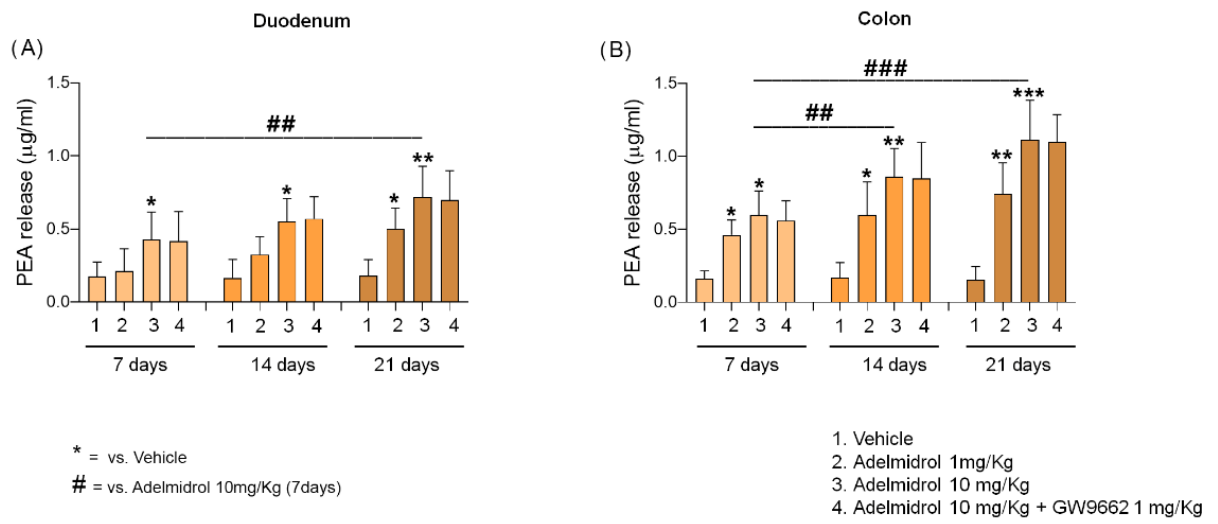
Figure 2. Effect of daily administration of Adelmidrol (1–10 mg/Kg) on PEA concentration in the duodenum ( A ) and colon ( B ) of treated mice, respectively, in the presence and absence of specific PPAR- γ inhibitor GW9662 (1 mg/Kg). PEA levels were measured at 7, 14, and 21 days. Results are expressed as mean ± SD of n = 4 experiments performed in triplicate. * p < 0.05, ** p < 0.01, and *** p < 0.001 respectively versus vehicle of the same timepoint. ## p < 0.01 and ### p < 0.001 respectively versus Adelmidrol (10 mg/Kg) at day 7.